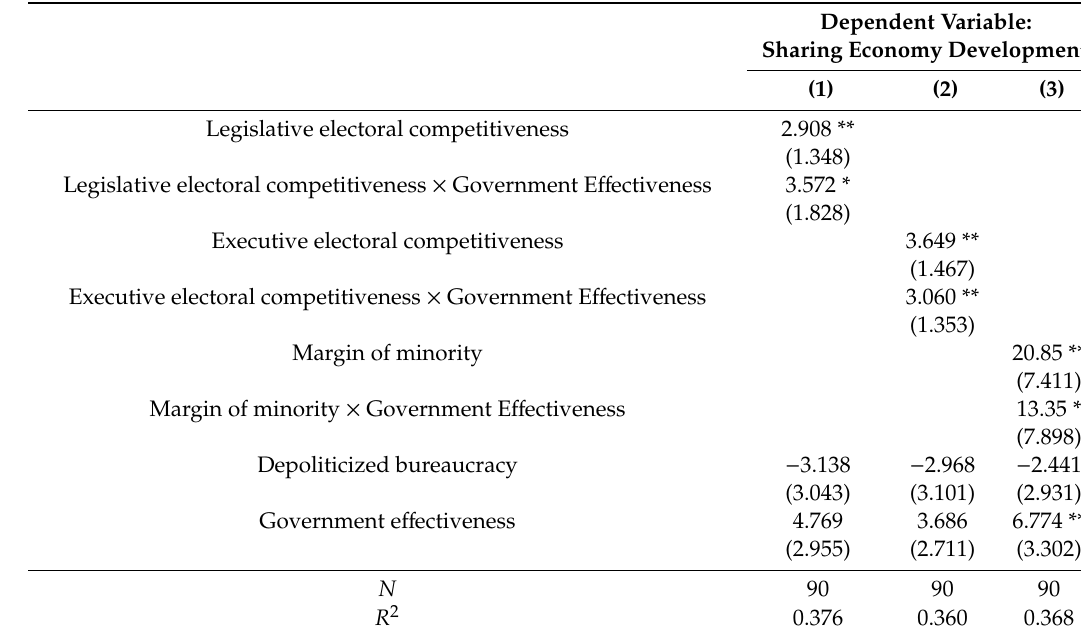
Table 5. Sharing economy development and qualities of government (Hypothesis